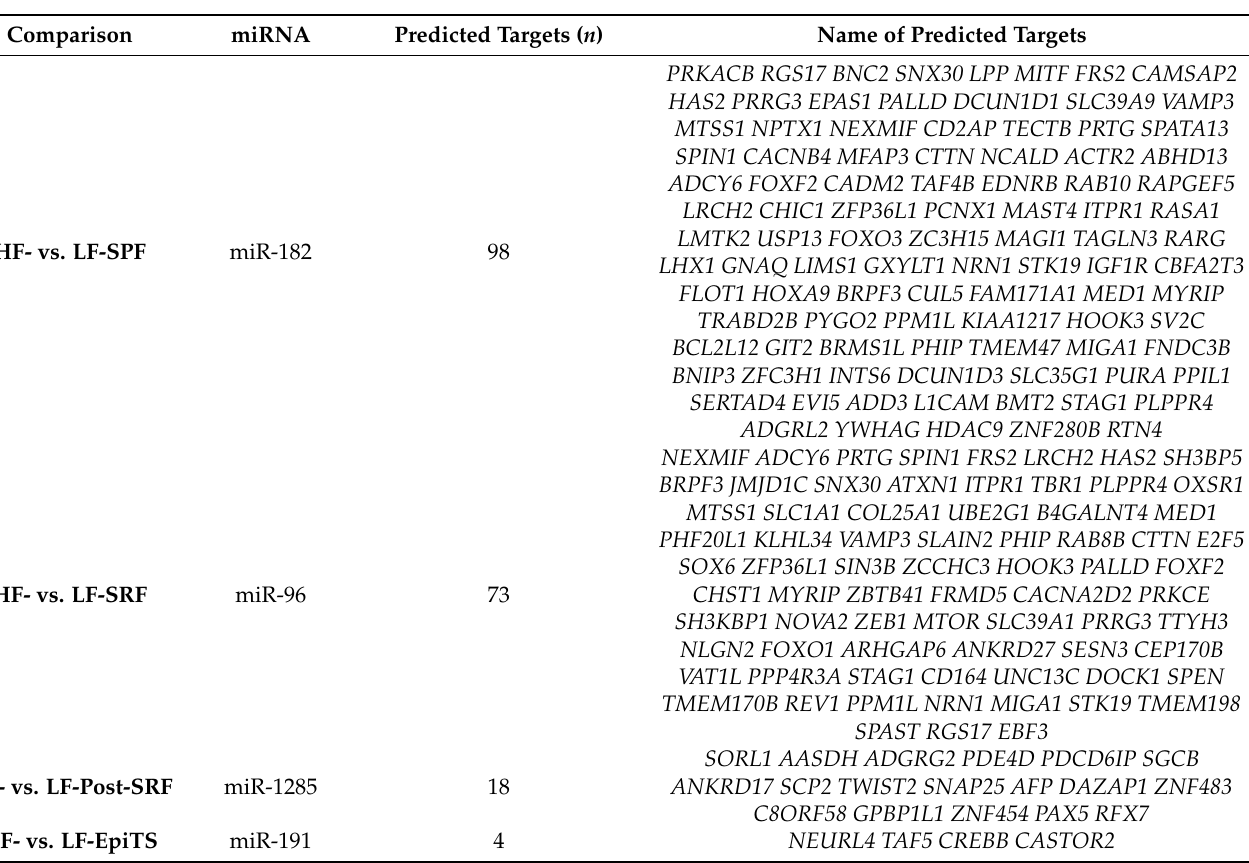
Table 5. List of predicted target genes of differentially expressed miRNAs ( p value < 0.05 and